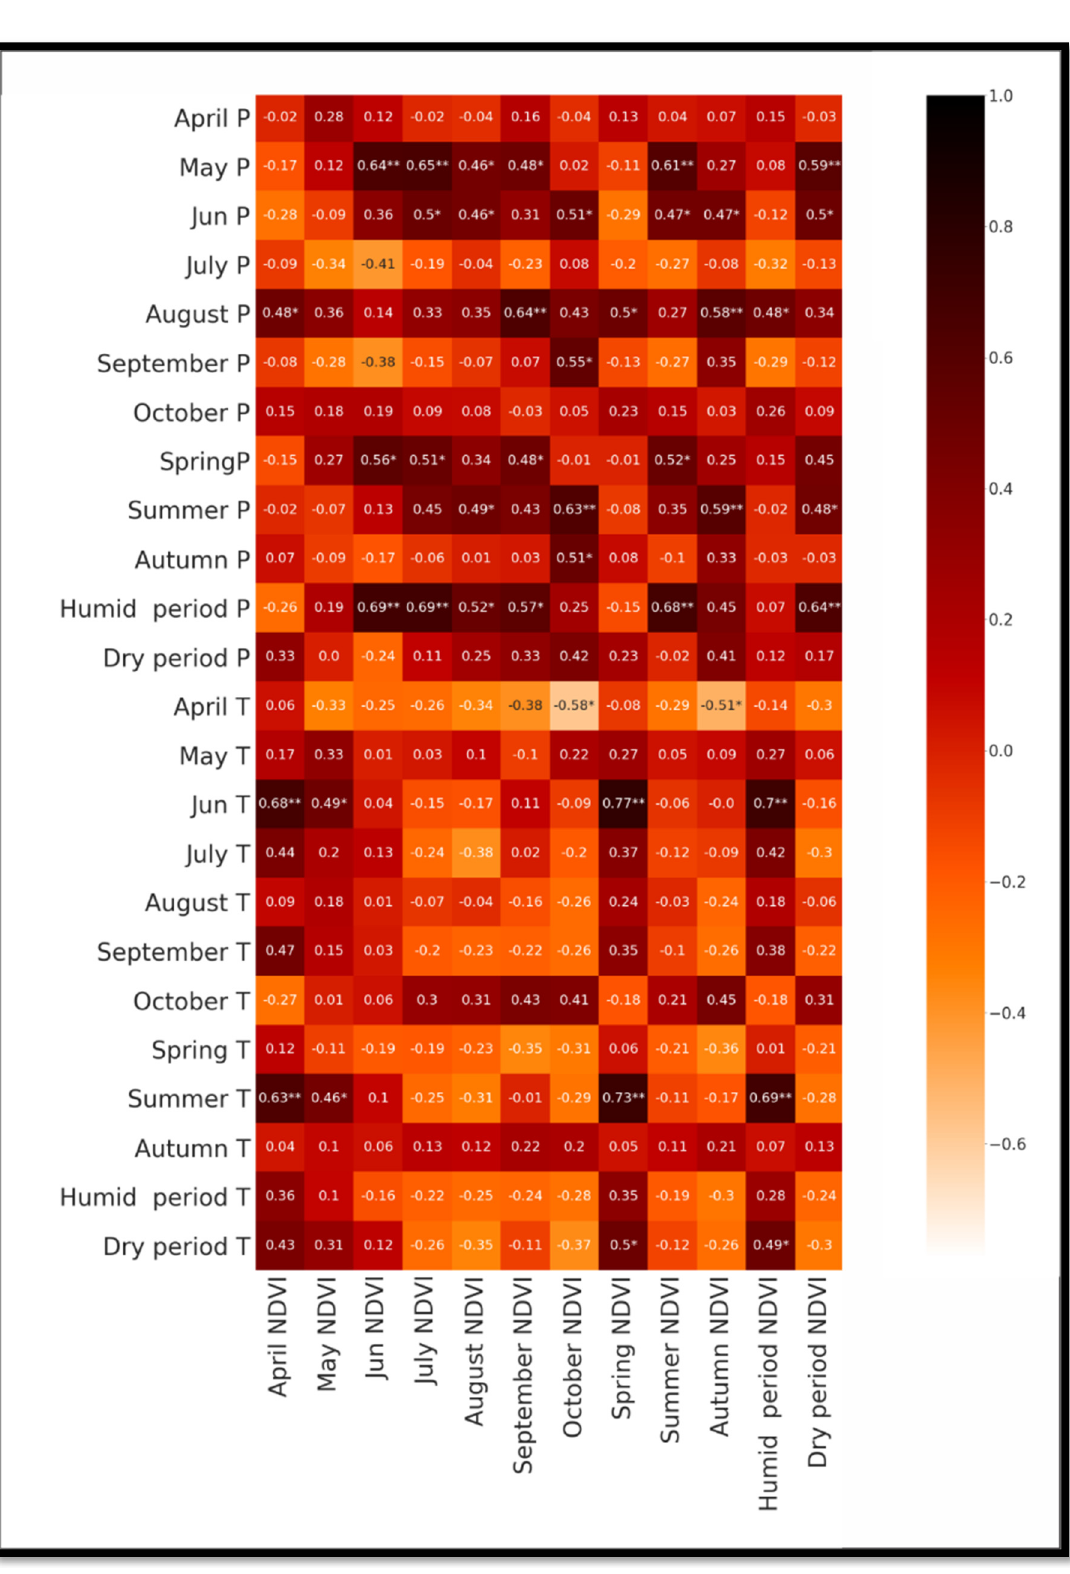
Figure 7. Correlation between temperature, precipitation, and the average monthly, seasonal LANDSAT NDVI data (with BRDF and topographic, atmospheric correction) for Meghri for the 2000–2018 period, with the levels of significance: *— p < 0.05, ** p <